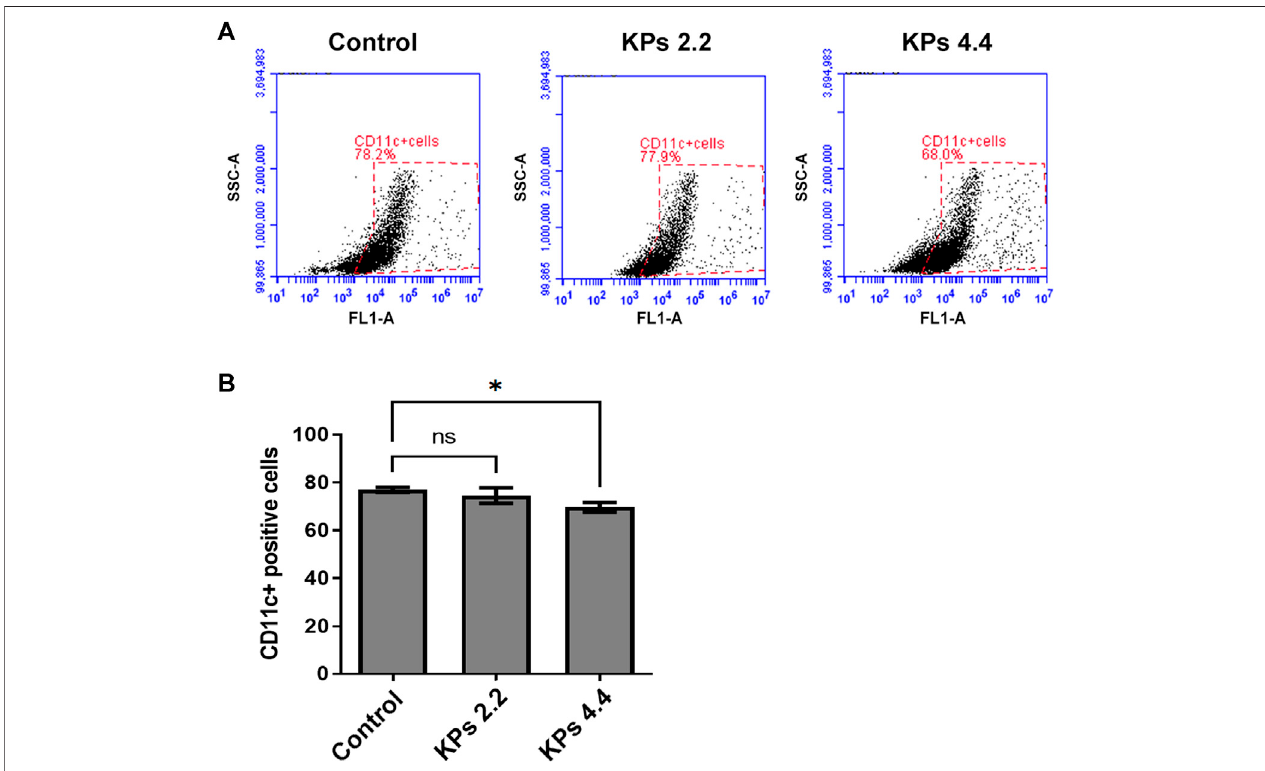
FIGURE7| EffectofKPsondifferentiationofCD11c + BMDCs. (A) FlowcytometryanalysisofthebivariategraphsofBMDCsofCIAmiceculturedwiththeindicated concentrationofKPsfollowedbyevaluationofCD11c + expressions. (B) Themean ± SDoftheexperimentaltriplicatesarepresentedinthebargraph.Experimentswere repeated three times independently. *** p < 0.001 vs 0.1% DMSO-treated mock group, as determined by a one-way ANOVA with Dunnett ’ s test.